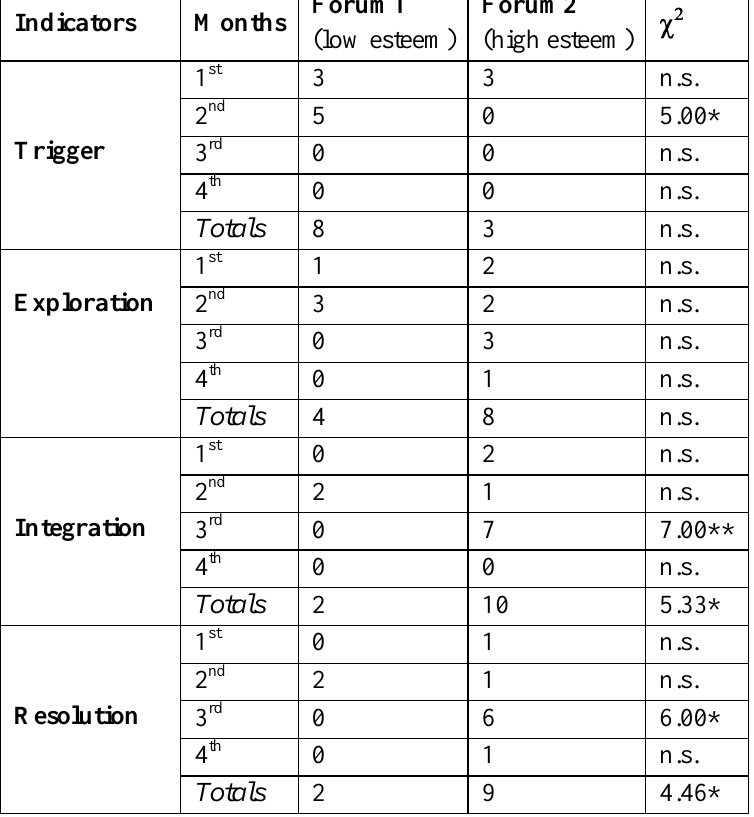
Table 5 Cognitive Presence: Instructors’ Postings Only